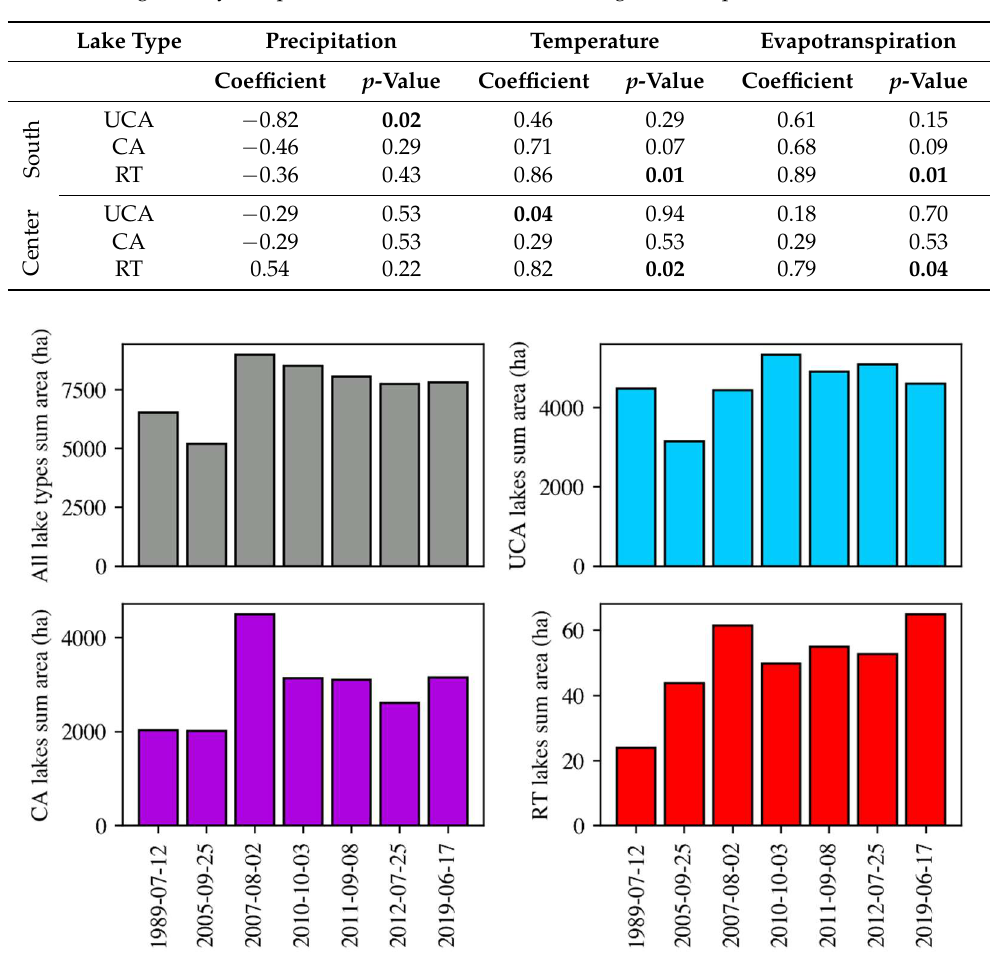
Table 4. Spearman coefficient values and p values related to the correlation of lake surface area with precipitation, temperature, and evapotranspiration. p -values < 0.05 are in bold. The datasets used are smaller than generally acceptable for robust correlation testing (>30 samples).